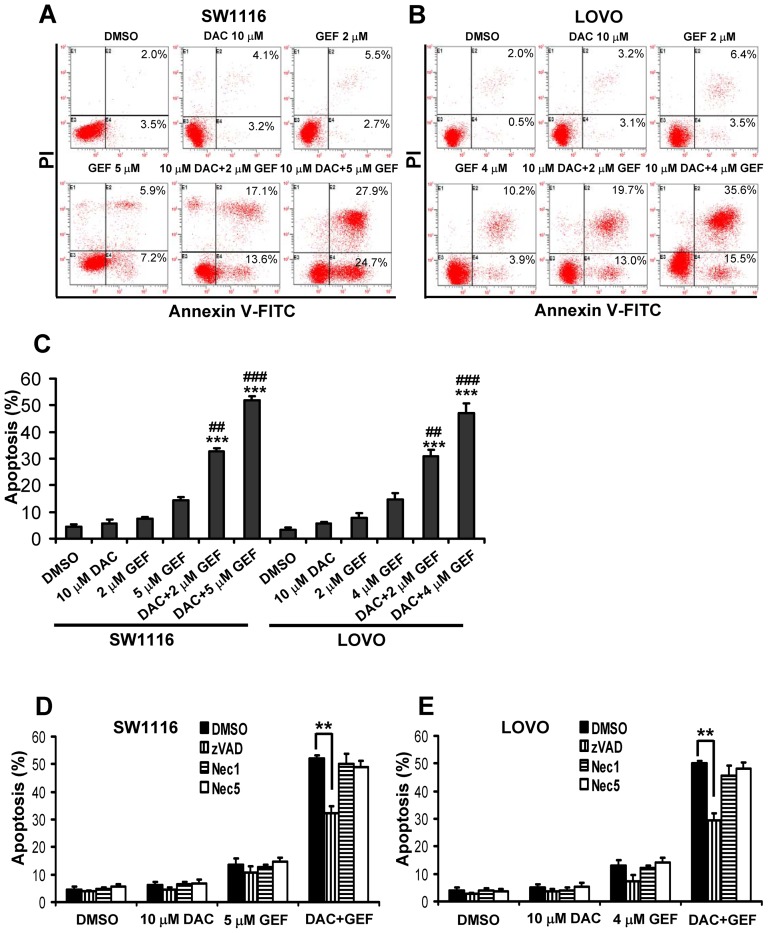
Decitabine synergistically enhances gefitinib-induced apoptosis in colon cancer cells.(A) and (B) SW1116 and LOVO cells were cultured in control conditions (DMSO) or in the presence of the indicated concentrations of decitabine (DAC) and gefitinib (GEF), alone or in combination, for 48 h. And then cells were stained with Annexin V-FITC and propidium iodide (PI) and analyzed by flow cytometry. This experiment was done in triplicate and representative diagrams of Annexin V-FITC assays are shown. (C) Quantitative measurement of Annexin V-FITC flow cytometry analyses showed positive apoptotic cells in response to DAC and GEF, alone or in combination. Columns, mean; bars, SD. **, P<0.01, ***, P<0.001, compared with DAC-treated cells. ##, P<0.01, ###, P<0.001, compared with GEF-treated cells. (D) and (E) SW1116 and LOVO cells were pre-treated with 10 µM z-VAD-fmk (zVAD) or 20 µM necrostatin-1 (Nec1) or necrostatin-5 (Nec5) for 1 h followed by treatment with the indicated concentrations of DAC and GEF, alone or in combination, for additional 48 h. And then the apoptotic cells were determined by Annexin V-FITC/PI staining and flow cytometry analysis. This experiment was repeated thrice. Columns, mean; bars, SD. **, P<0.01.